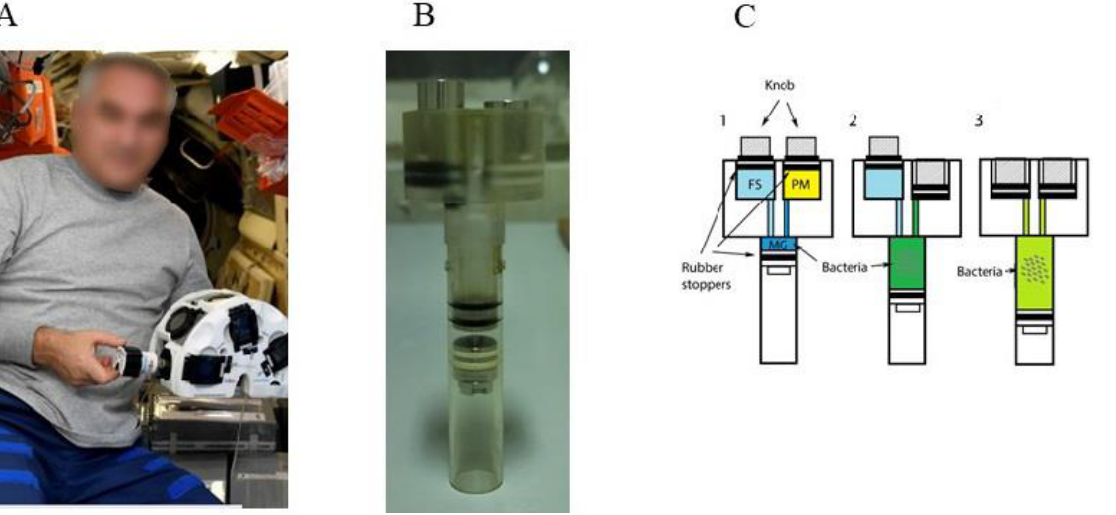
Figure 4. The magnetic bioassambler “Organ.Aut” used in space studies. ( A )—the cosmonaut of Roscosmos, performing the experiment with “Organ.Aut” aboard the ISS; ( B )—the working cuvette; ( C )—the scheme of cuvette using: 1: before the start of the experiment bacteria were placed in the Melbiol hydrogel (MG), the nutritive paramagnetic medium (LB + 1 M Gadovist, PM) and fixation solution (FS) were in the isolated chambers; 2: then the cosmonaut pushed a button to mix MG and PM, and bacteria started to grow; 3: at the end of the experiment, the cosmonaut pushed a second button to fix bacteria; the total system hermetically sealed without air bubbles. Figure modified from